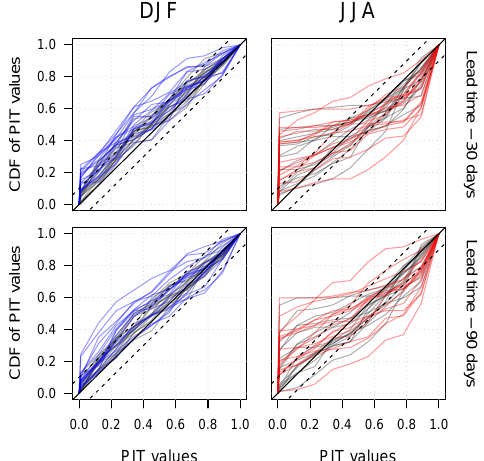
Figure 3. PIT diagram of raw precipitation forecasts (coloured lines) and historical precipitation (grey lines) for lead times of 30 days (top) and 90 days (bottom). Each column corresponds to a tar- get season. Each line represents the PIT diagram in a catchment for forecast horizons within the target season. Dotted lines represent the ± 0.1 tolerance bands from the diagonal.